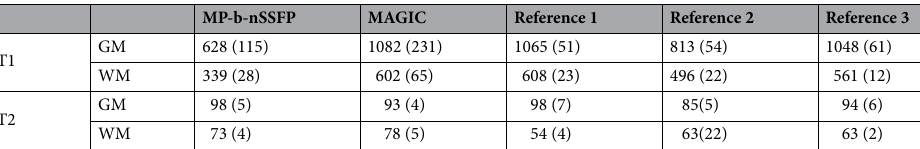
Table 1. T1 and T2 values estimated in gray and white matter from the prosposed method, MP-b-nSSFP and MAGIC. Standard deviations are expressed in parenthesis. Reference columns respectively are: (1) Deoni et al. 30 , (2) Shcherbakova et al. 31 and (3) Warntjes et al. 25 .